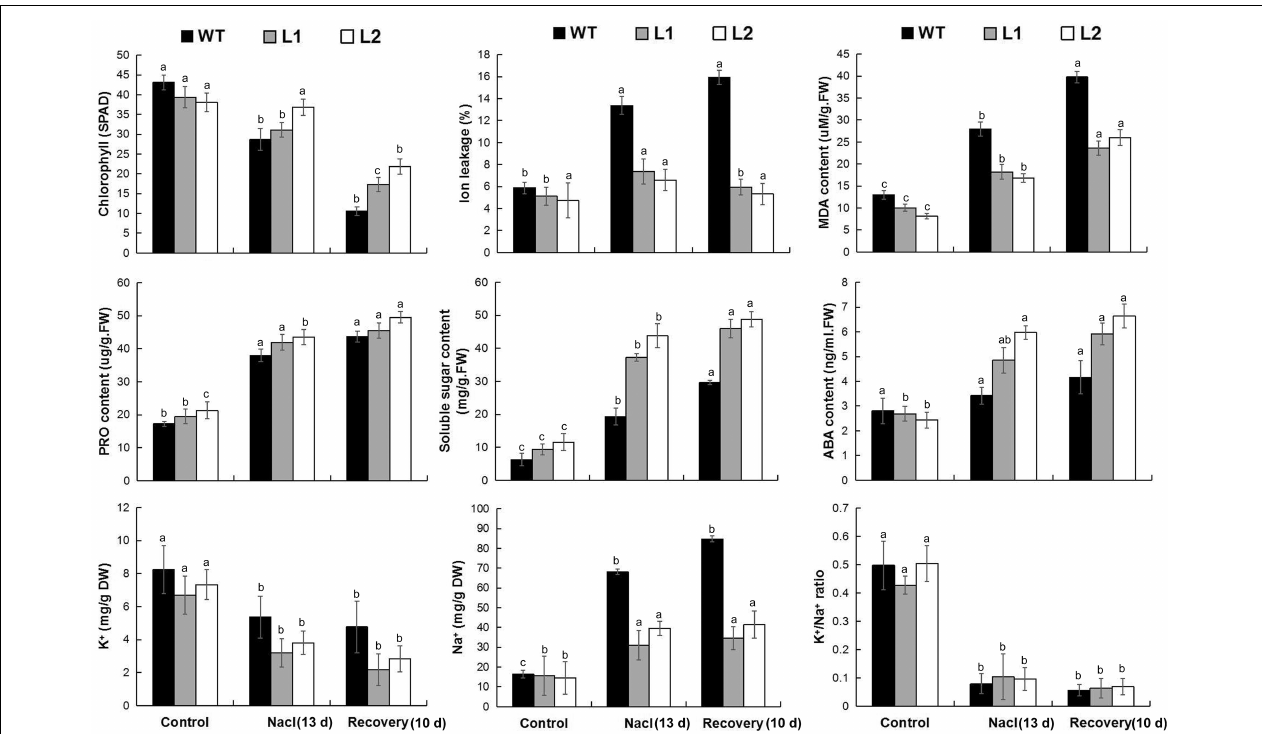
FIGURE 6 | Comparisons of physiological indices between WT and transgenic plants under normal, salt, and recovery conditions. Control means banana seedlings (100-day-old) grow normally. NaCl means banana seedlings (100-day-old) were subjected to salt treatment (250 mM NaCl) for 13 days, and recovery means banana seedlings (100-day-old) growth recovery for 10 days following 13-day salt treatment. Data are means ± SD of n = 3 biological replicates. Means denoted by the same letter are not significantly different at P < 0.05 as determined by Duncan’s multiple-range test.